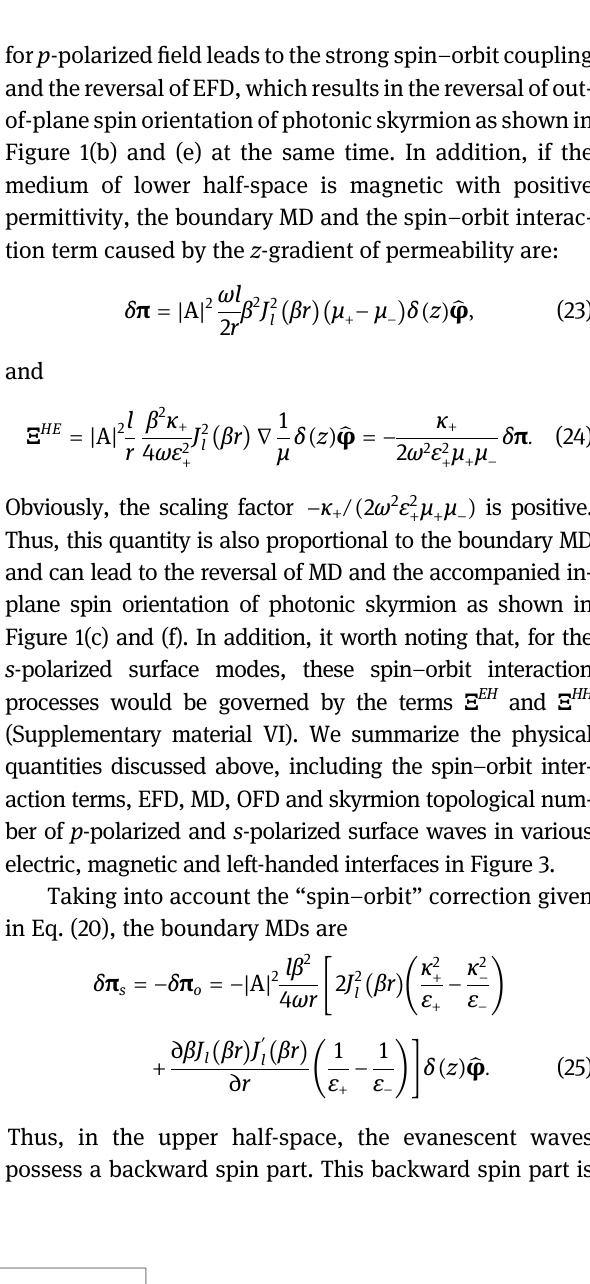
Figure 3: Summary of physical quantities for the p -polarized and s -polarized surface wavesinvariouselectric,magneticandleft- handedinterfaces.Here,topologicalcharge l > 0; if the l is inverse, the direction of all quantities are inverted. The corresponding available “ spin – orbitinteraction ” termsare given in the